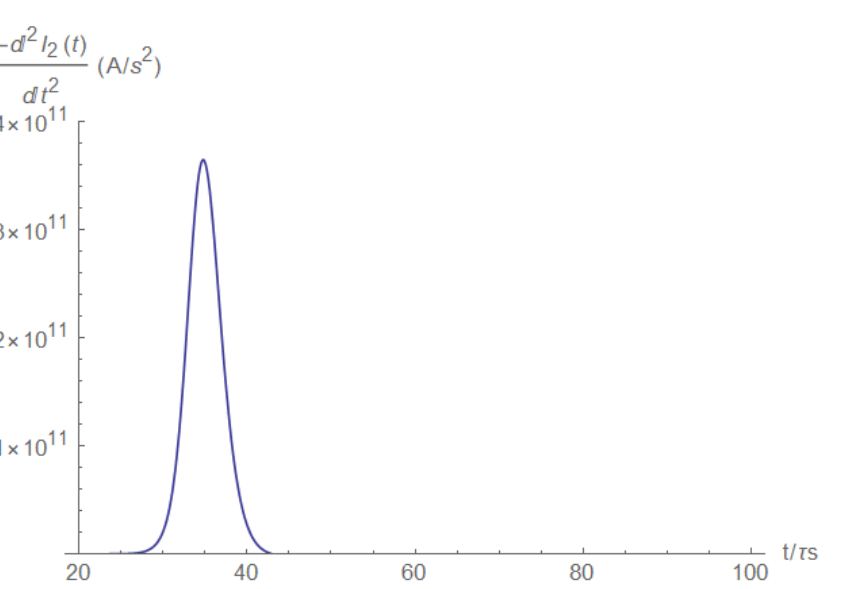
Figure A23. The load current derivative.